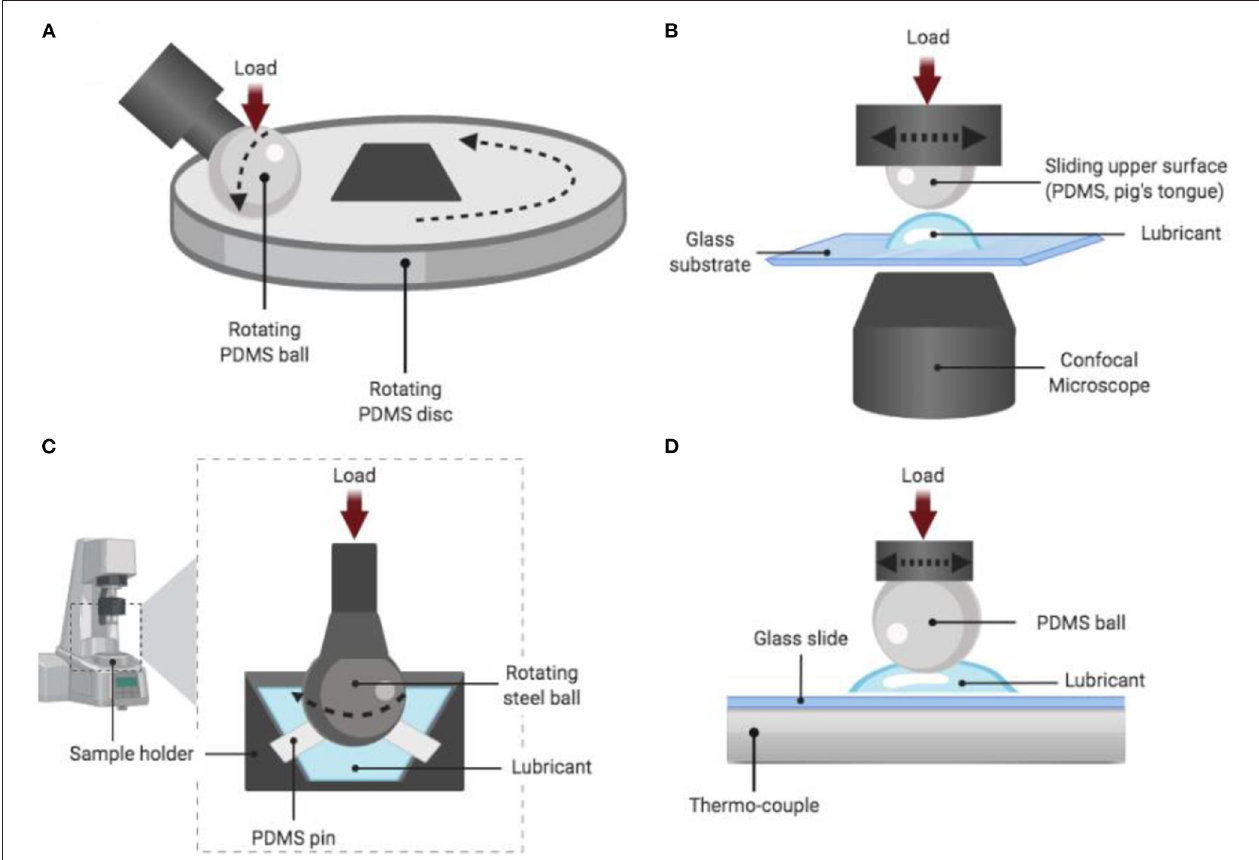
FIGURE 3 | Scheme of the most used equipment for tribological measurement. (A) Mini-traction machine in a ball on disk configuration (MTM); (B) Optical tribometer configuration (OTC); (C) Anton-Paar ball on three pins rheometer attachment and (D) High-Frequency Reciprocating Rig (HFRR) device. NOTE: Polydimethylsiloxane (PDMS) is an example of the surface, but other materials can be used. Figure edited from Shewan et al. ( 6) and Tsui et al.